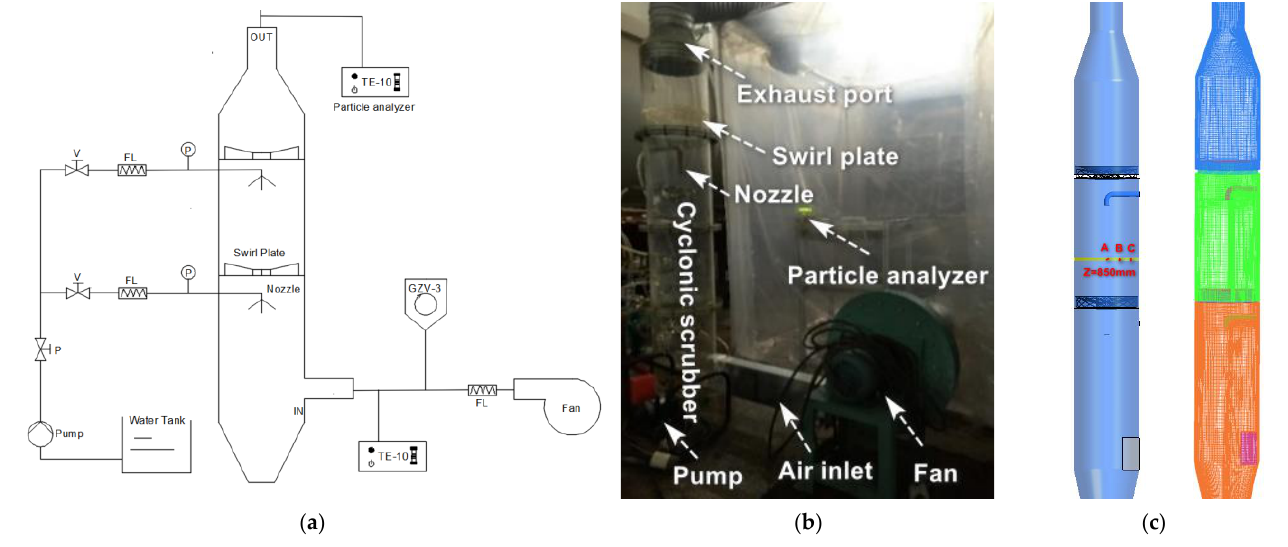
Figure 1. Cyclonic spray scrubber system: ( a ) Schematic diagram; ( b ) Experimental field setup; and ( c ) Geometric model (measure points A, B and C) and Computational grid.